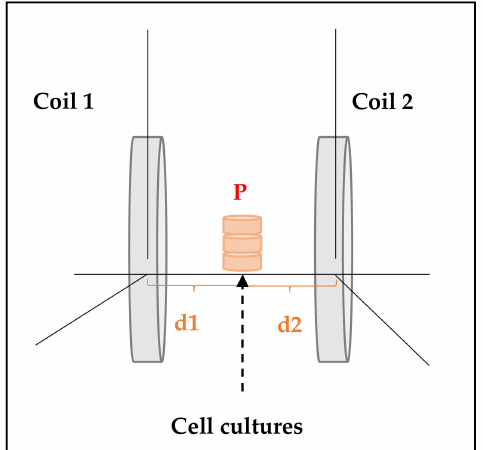
Figure 3. ELF-electromagnetic field (EMF) exposure system’s scheme. For each experiment, three culture dishes (diameter = 35 mm) were placed in a point P equidistant to coil 1 and coil 2 (i.e., distance d1 from point P to coil 1 was equal to distance d2 from point P to coil 2) [1]. In order to guarantee the adequate physiological condition for the cultures (i.e., 37 ◦ C, 5% CO 2 and 95% humidity) the pair of coils were kept inside a cell incubator and isolated from external EMF by a mu-metal box